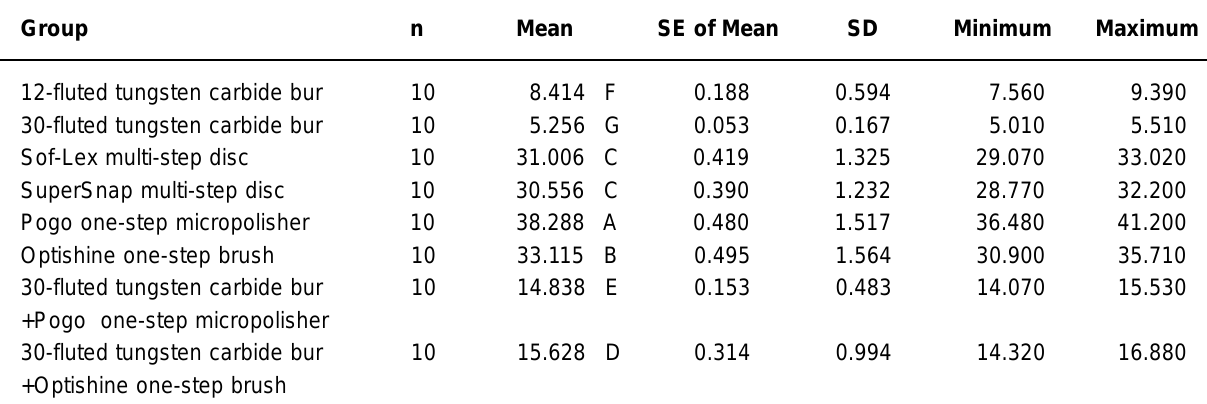
n: number of specimens; SE: Standard error; SD: Standard deviation. Different letters indicate statistically significant difference between the mean values of the